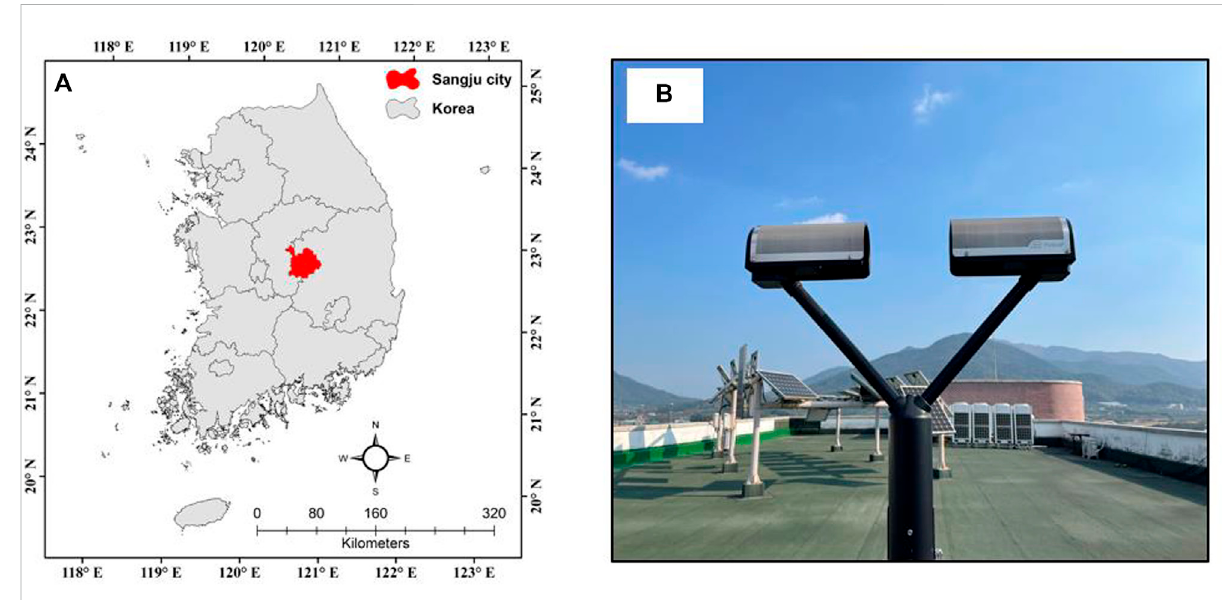
FIGURE 1 (A) Location of Sangju city and (B) the Parsivel 2 disdrometer located inside the Kyungpook National University